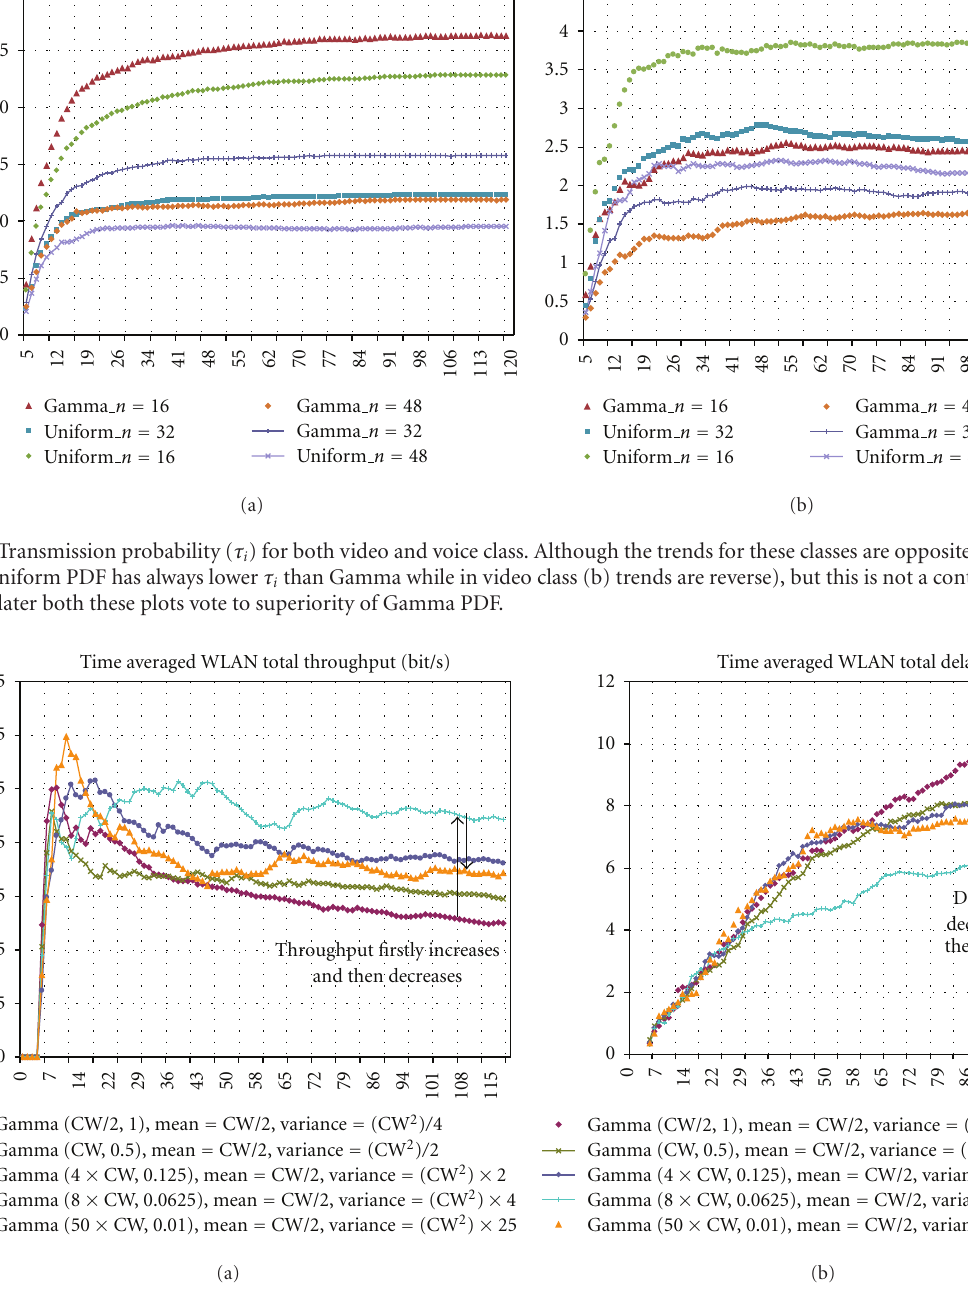
Figure 9: Total throughput and total delay for five di ff erent scenarios with the same Gamma PDF mean but di ff erent variances ( n = 24). With variance increment, Intra-class contention takes place of Inter-class contention. (right): Total delay firstly decreases (gets better) and after a limit increases (gets worse). (left), Total throughput firstly increases (gets better) and after a limit decreases (gets worse).